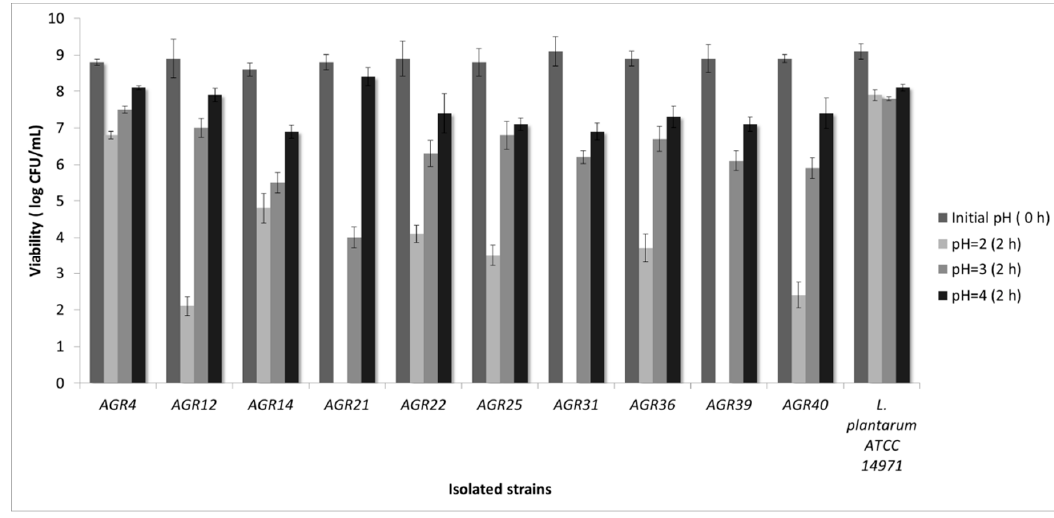
Figure 1. Evaluation of strain viability after exposure to low pH for 0 to 2 h.